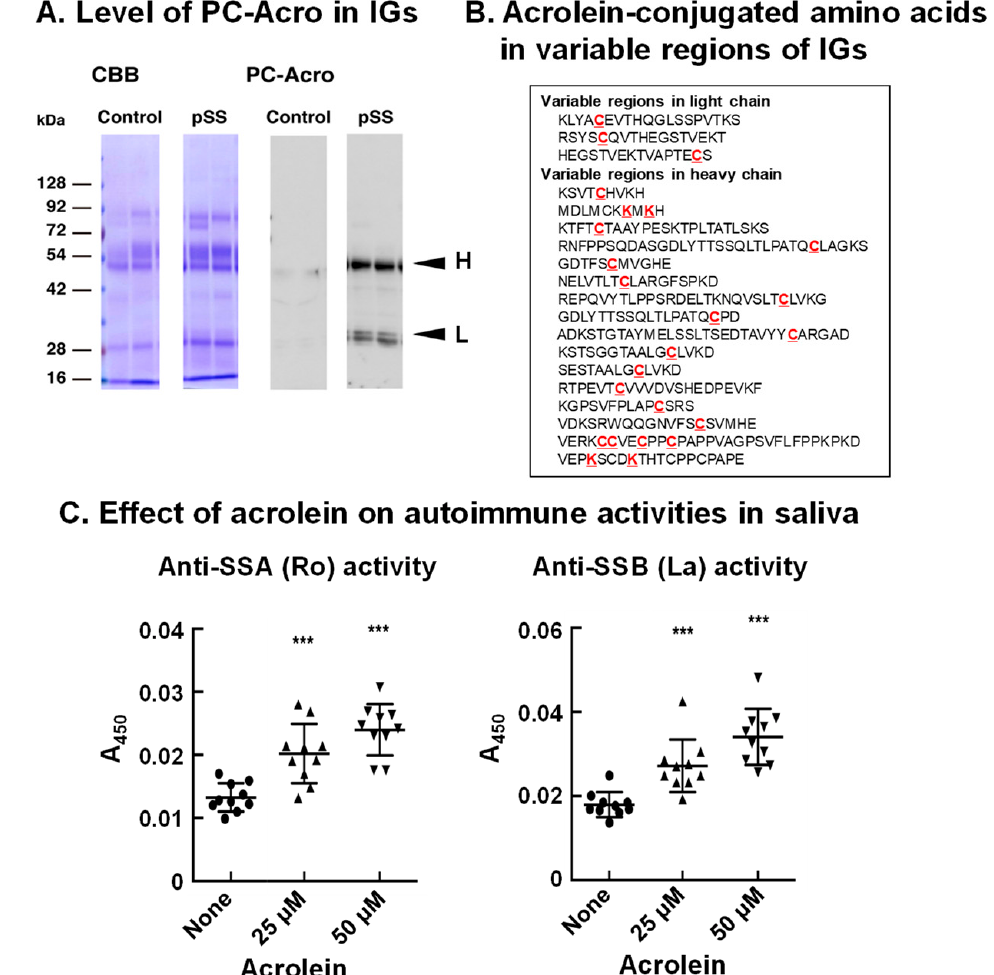
Figure 7. Increase in acrolein-conjugated immunoglobulins in pSS patients and determination of amino acids conjugated with acrolein in immunoglobulins. ( A ). Levels of acrolein-conjugated light and heavy chains of immunoglobulins in saliva from control and pSS subjects. ( B ). Acrolein-conjugated amino acids shown in red in variable regions of immunoglobulins in saliva from 11 pSS patients. ( C ). Effect of acrolein on recognition activities for Ro and La. Acrolein treatment at 37 °C for 48 h. ***, p < 0.001. Adapted with permission from Ref. [13]. 2015 Elsevier.